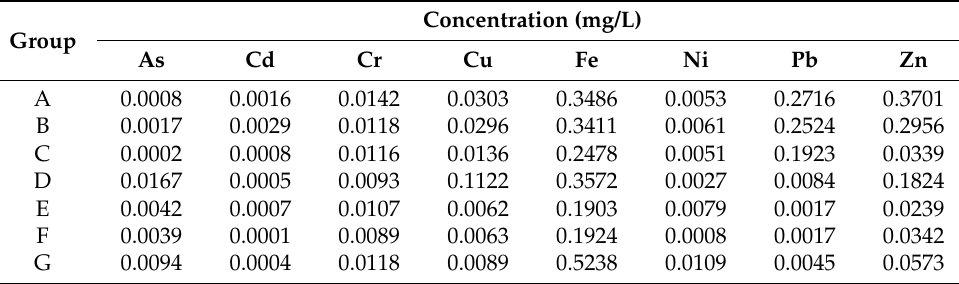
Table 5. Concentrations of heavy metals in flue gas (mg/L) for Groups A–G.